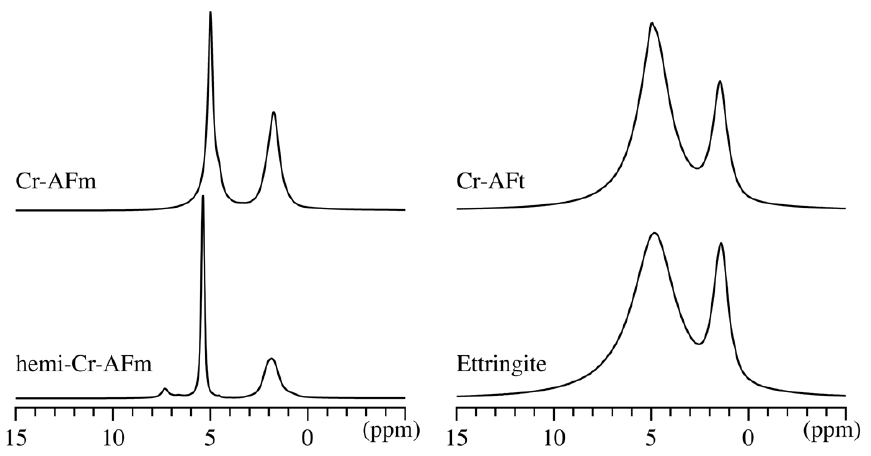
Figure 7. 1 H MAS NMR spectra (22.3 T) for monochromate ( ν R = 40 kHz), hemichromate ( ν R = 40 kHz), chromate AFt ( ν R = 35 kHz), and ettringite (SO 4 -AFt) ( ν R = 40 kHz). The main peaks are observed at 5.01 ppm and 1.77 ppm (Cr-AFm); 5.40 ppm and 1.92 ppm (hemi-Cr-AFm); 4.86 ppm